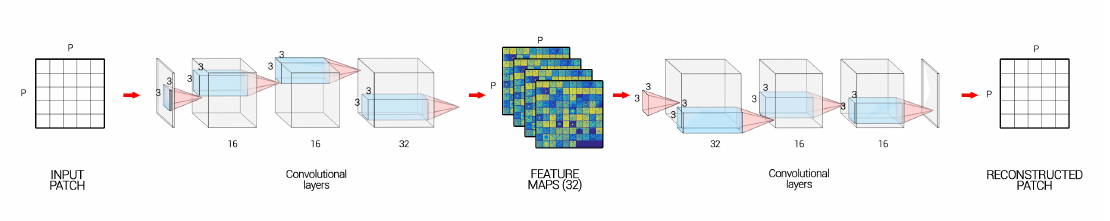
Figure 3. Autoencoder architecture for our